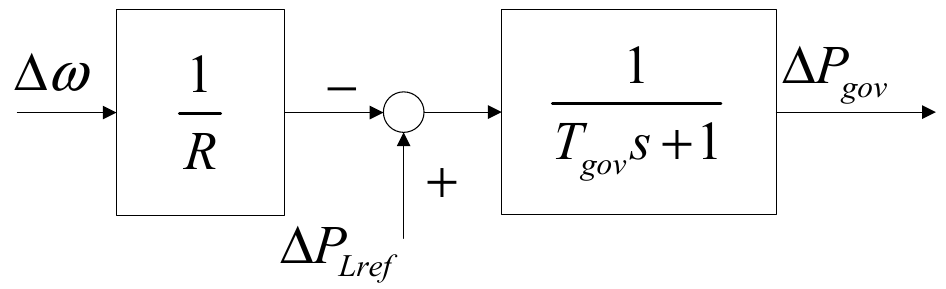
Figure 3. Structure of the transfer function of the governor.